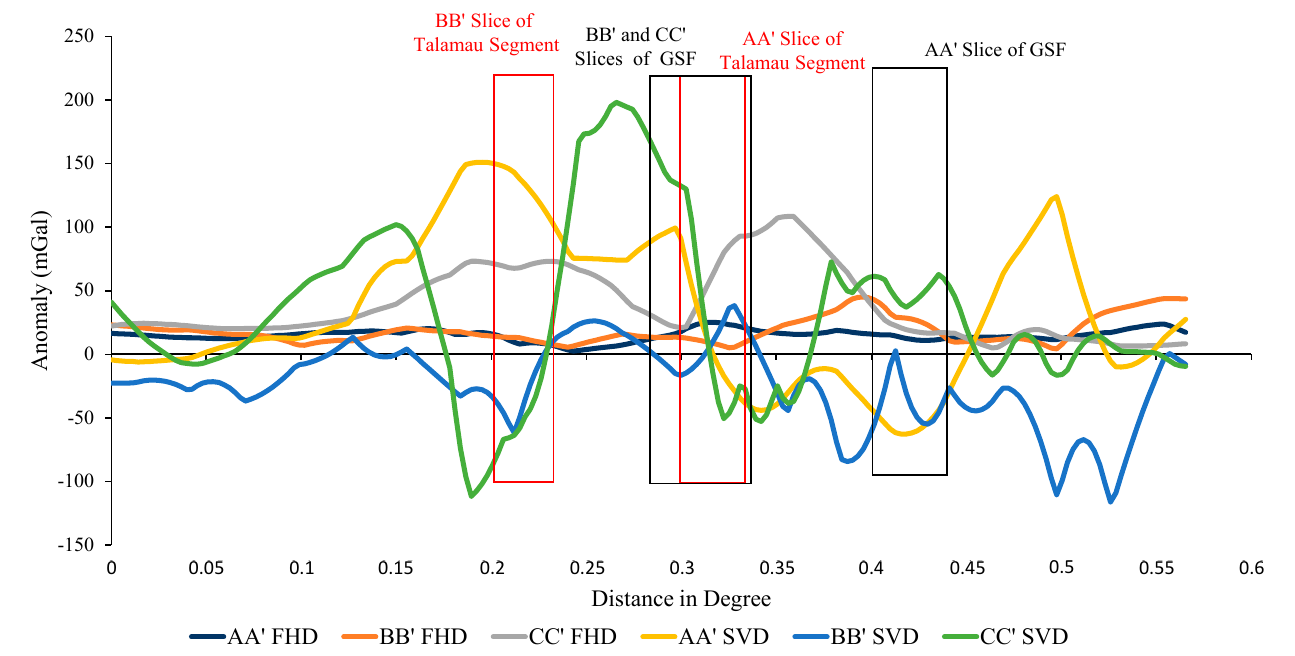
Figure 12. Results of AA’ FHD, BB’ FHD, CC’ FHD, AA’ SVD, BB’ SVD, and CC’ SVD is symbolized by dark blue, orange, gray, yellow, blue, and green lines. Red rectangles show the new fault segment, the Talamau segment, while the black rectangles show the old segment.